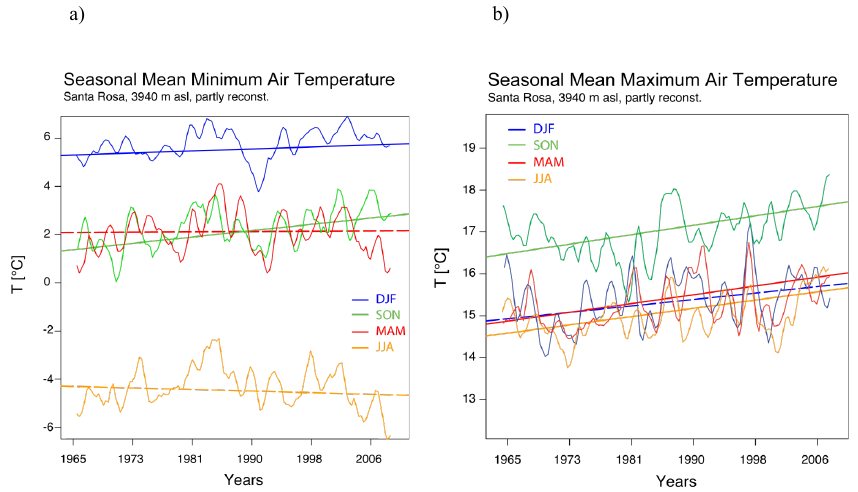
Fig. 5. Seasonal mean minimum (a) and maximum (b) air temperature for Santa Rosa station. Shown are the normalized and fitted (2-sided moving average) time series. Dashed trend lines indicate where the p-value is above the significance level 0.05 (cf. also Table Figure 5. Seasonal mean minimum (a) and maximum (b) air temperature for Santa Rosa 14 station. Shown are the normalized and fitted (2-sided mov. Avg.) time series. Dashed trend 15 lines indicate where the p-value is above the significance level 0.005 (cf. also Table 6) 16